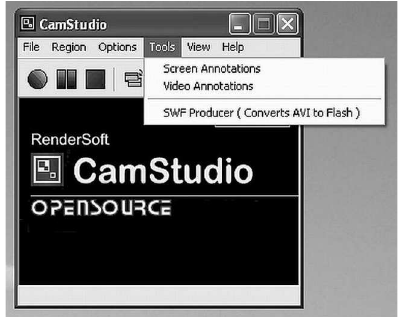
Figure 6. CamStudio allows users to convert AVI files into flash animations